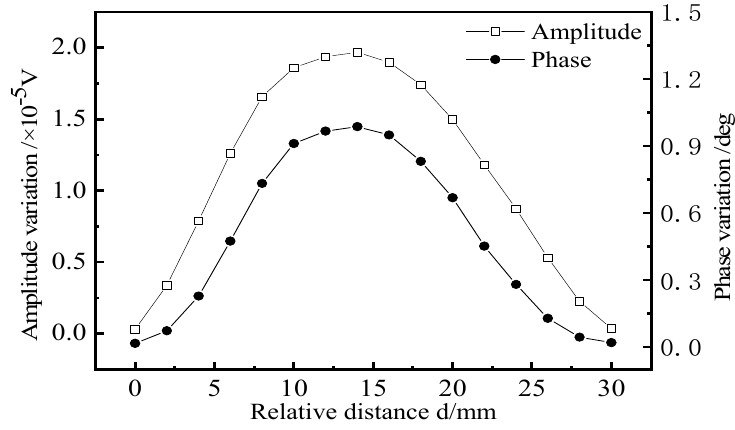
Figure 14. Influence of excitation coil position on detection signal.